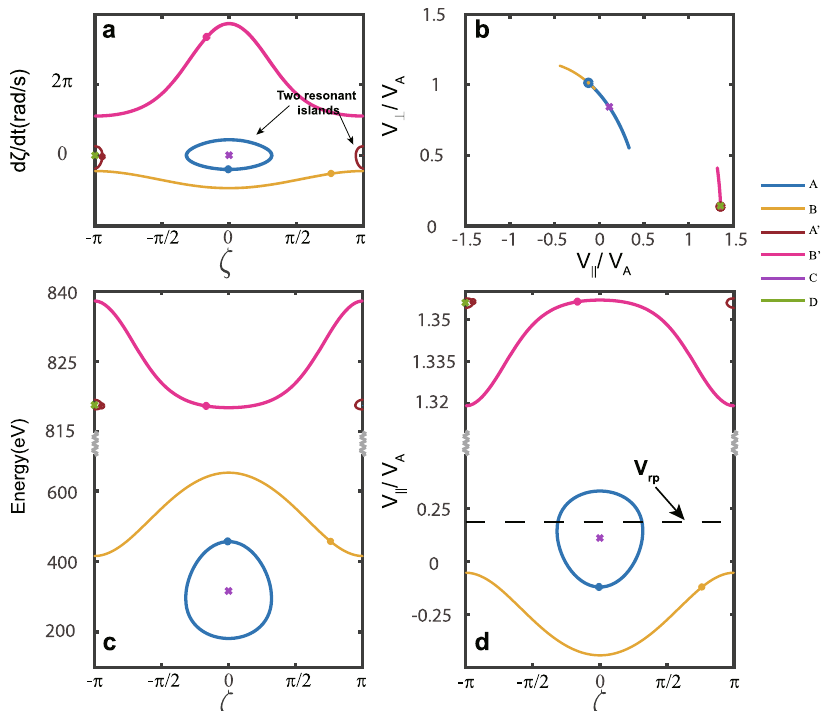
ζ phase space, in which v V k - k is also normalized by A . The